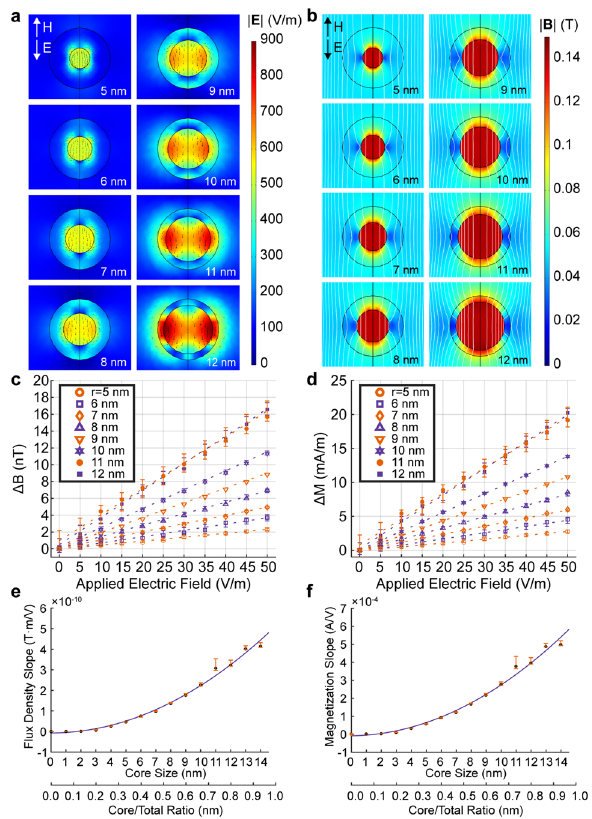
Figure 2. Effect of MENP core size on electric field-based magnetization modulation. ( a ) The effect of core size on electric field magnitude (colormap) and direction (vectors) in response to external fields. The core radius ranged from 5 to 12 nm corresponding to shell thickness ranging from 10 to 3 nm. In all cases, E z = − 100 mV/ mm antiparallel to H z = 4 kA/m. ( b ) Magnetic flux density plots for the same configurations in ( a ). ( c ) Volume- averaged changes in magnetic flux in response to electric field for the same core sizes. ( d ) Volume-averaged changes in magnetization in response to electric field, across the same core sizes. ( e ) Slope of the magnetic flux modulation versus electric field linear slope. ( f ) Slope of the magnetization modulation versus electric field linear slope. For both ( e ) and ( f ), the abscissa is labeled with both core size and core/total ratio. Error bars denote 95% confidence intervals for all